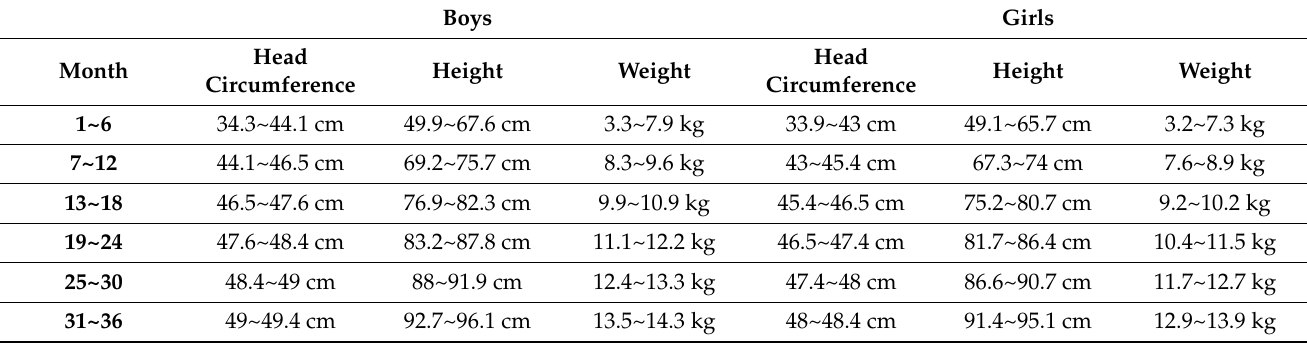
Table 1. Data of some body parts (head circumference, height and weight) of children aged 0–3. Boys Girls